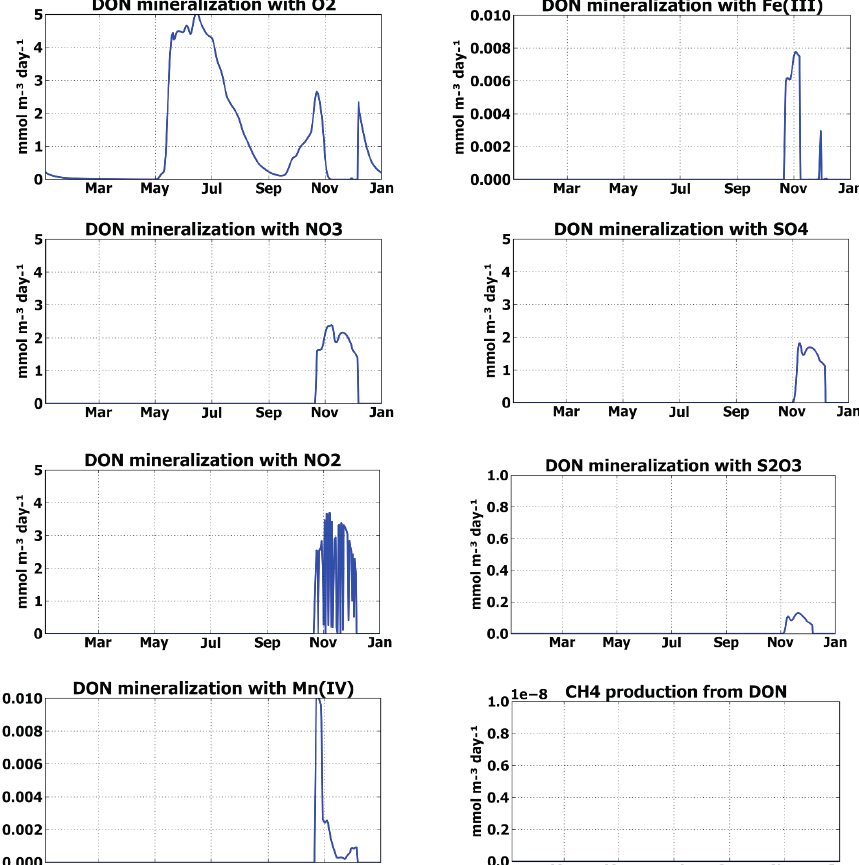
Figure 5. Simulated seasonal variability of biogeochemical transformation rates just above the sediment water interface, showing the rates of DON mineralization with oxygen, nitrate, nitrite, Mn(IV), Fe(III), SO 4 , S 2 O 3 , and CH 4 production from DON. Units are in mmol m − 3 d − 1 .